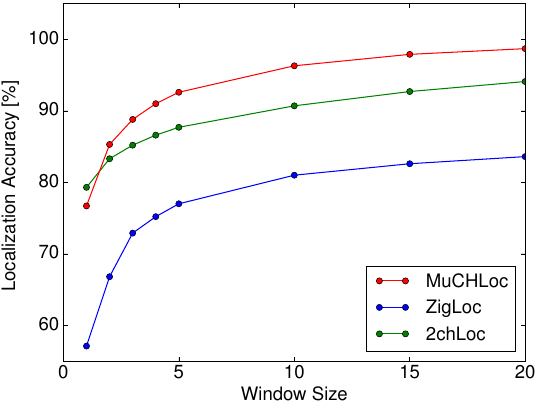
Figure 9. Localization accuracy as a function of window size w